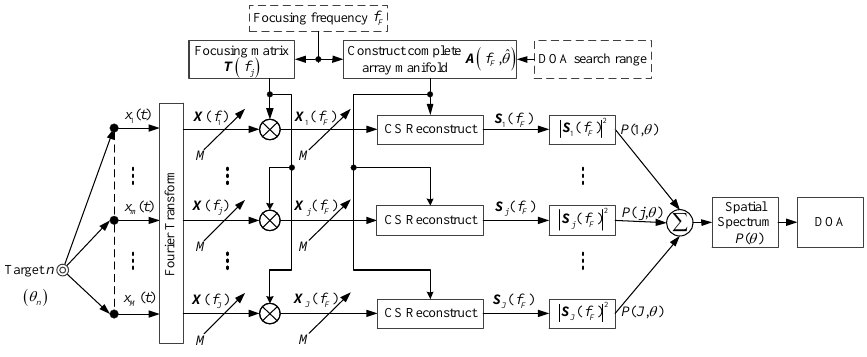
Figure 1. Wideband target DOA estimation model.